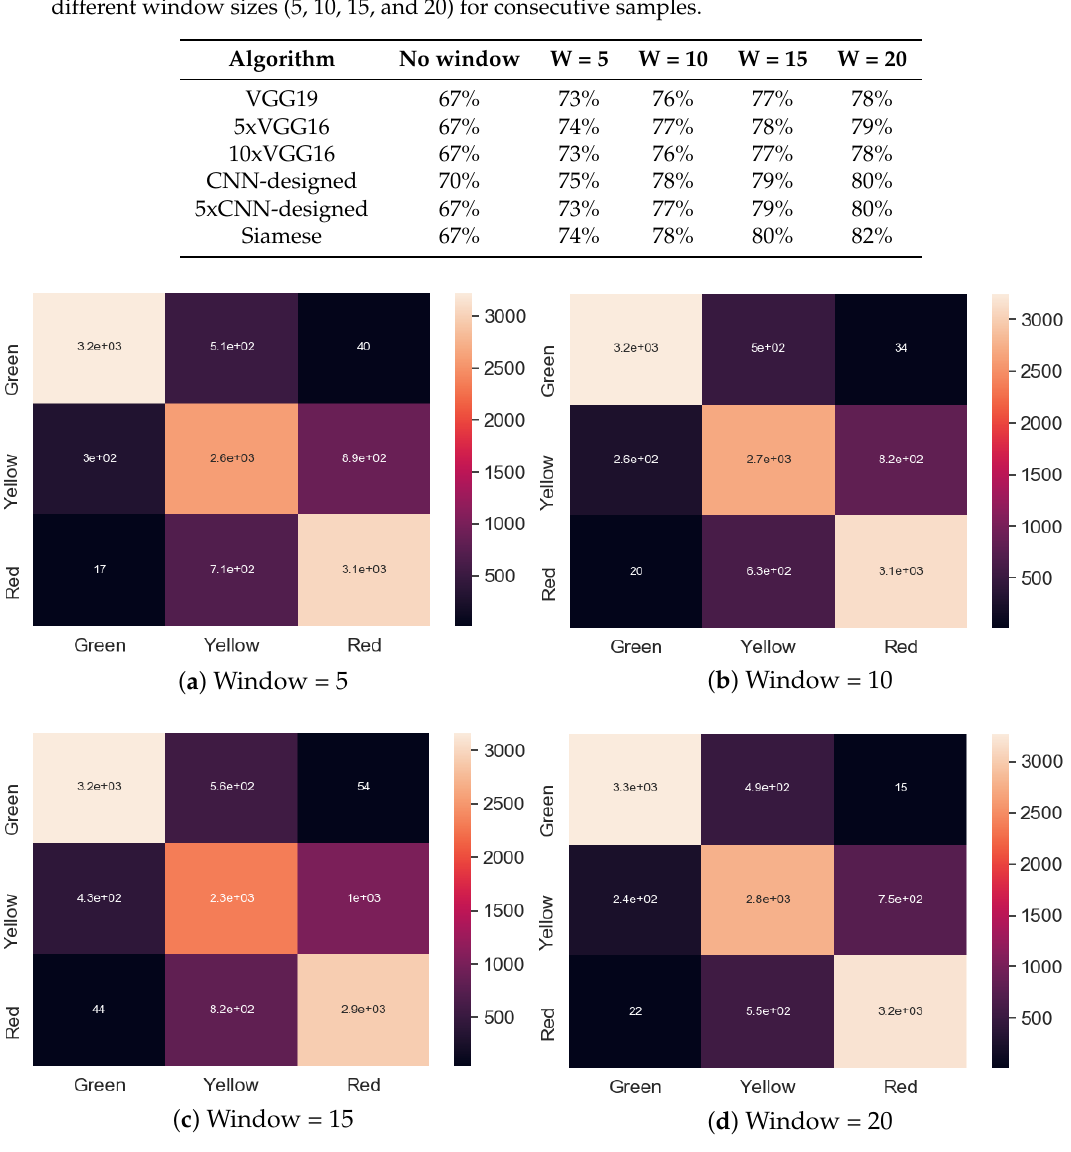
Figure 9. Confusion matrix for the Siamese model with different